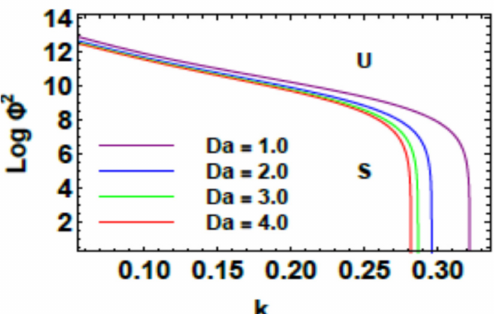
Figure 7. Plots of the stability bound for Da for different values the parameter k versus Log Φ 2 .